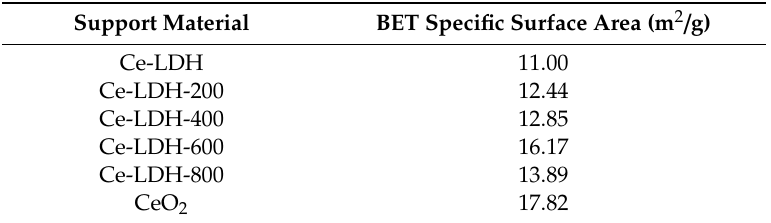
Table 3. BET specific surface area for the CeO 2 and Ce-LDH